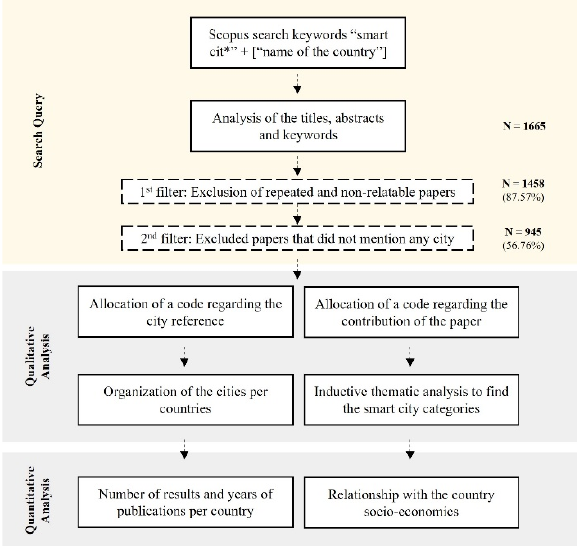
Figure 3. Detailed methodological approach to analyzing the literature.